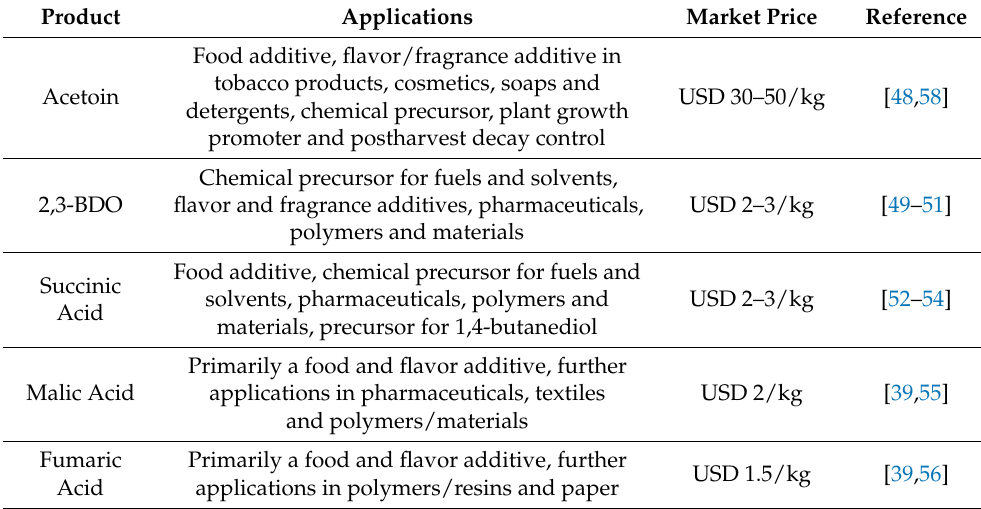
Table 1. Details on the existing applications of highlighted C4 platform chemicals.